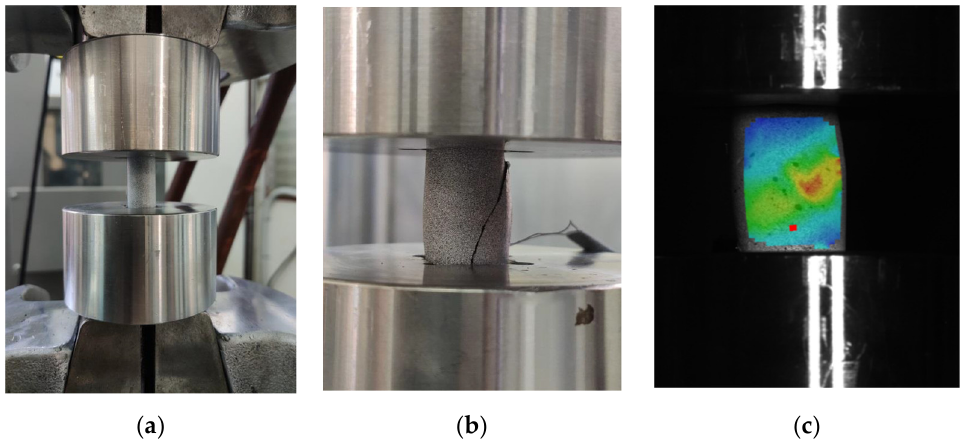
Figure 2. Specimen in the testing machine. ( a ) before experiment; ( b ) after experiment; ( c ) digital image correlation.